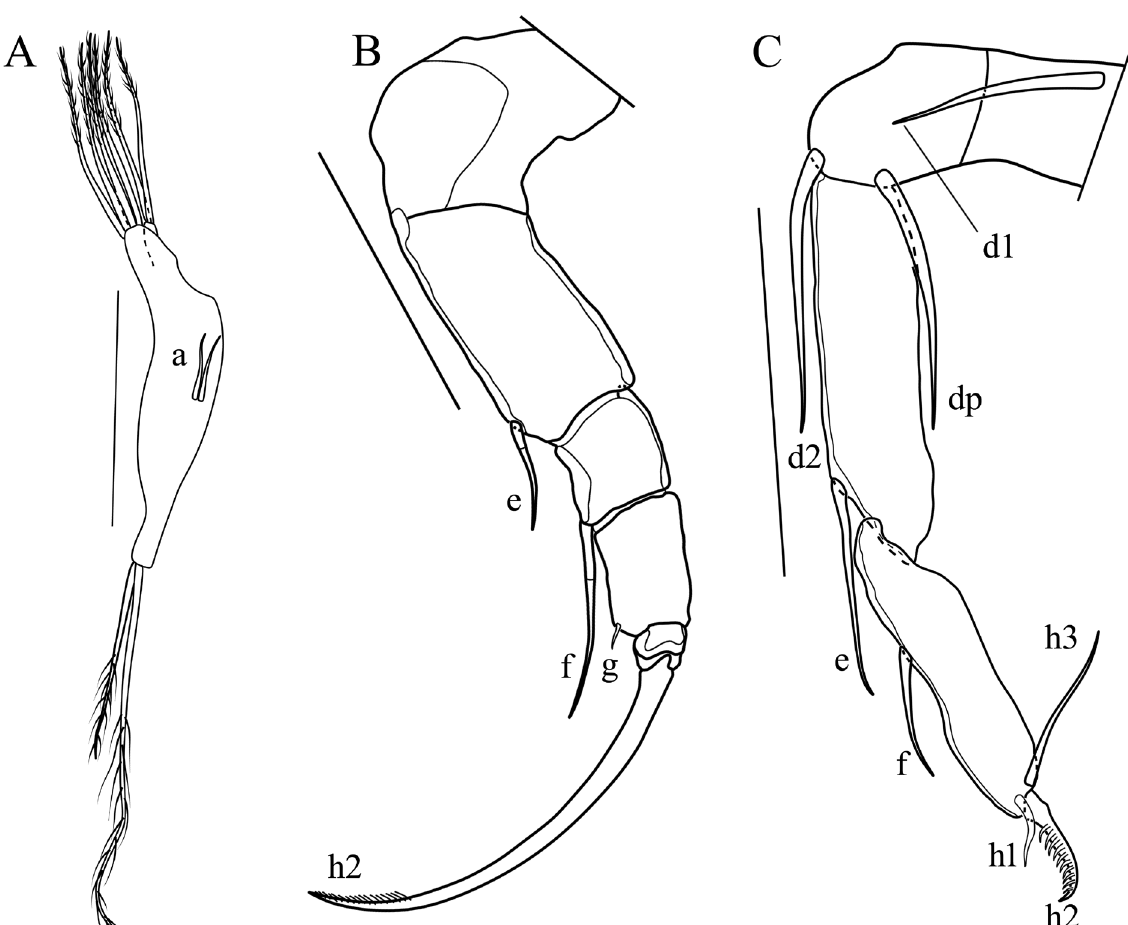
Fig. 21. Paranadopsis reducta gen. et sp. nov. from the Upper Paraná River floodplain, ♀. A . T1 (MZUSP 41868). B . T2 (MZUSP 41867). C . T3 (MZUSP 41869). Abbreviations: see text and Material and methods. Scale bars: 50